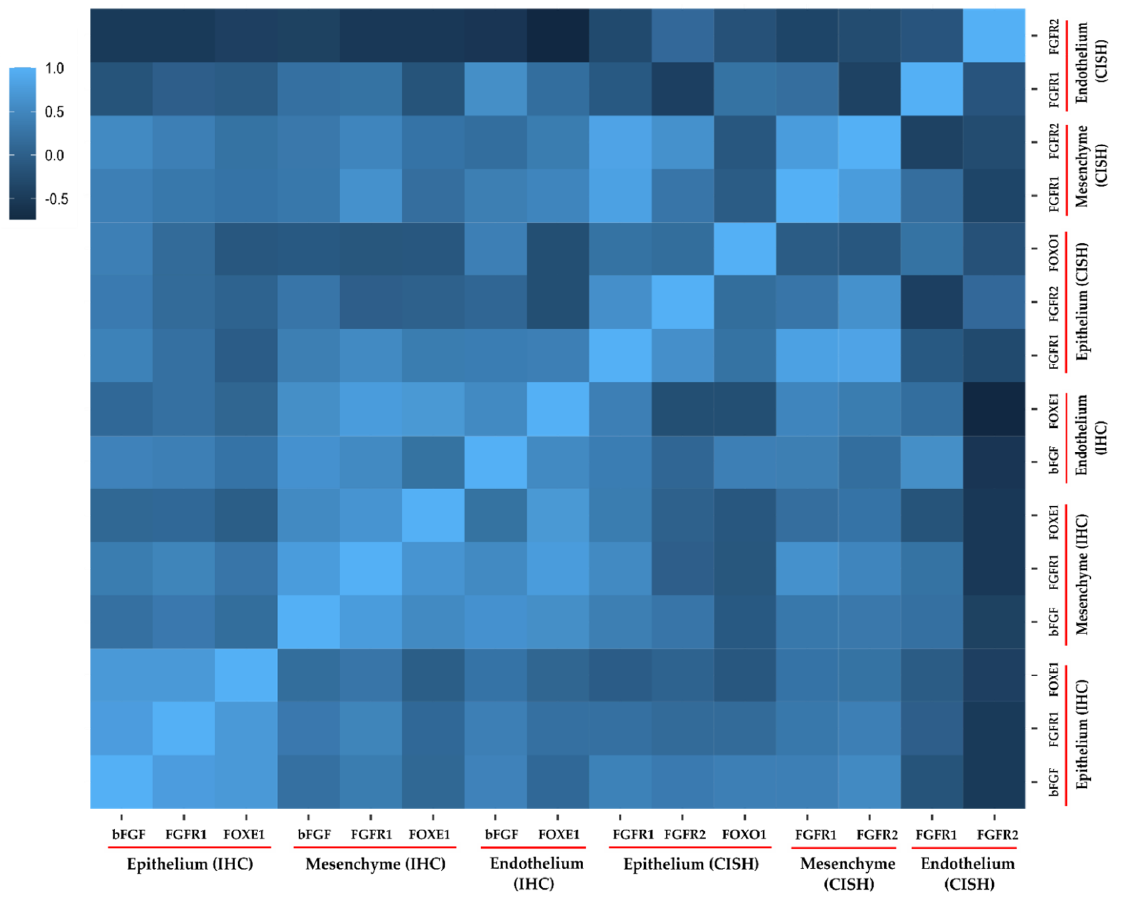
Figure 4. Correlation heatmap for different genes/proteins studied in the present study. The legend shows the correlation strength as determined using Spearman’s rho ( ρ ). Mesenchyme refers to connective tissue. A standard interpretation scale was used, i.e., 0.01 to 0.19 indicated no correlation; 0.20 to 0.29 indicated a weak correlation; 0.30 to 0.39 indicated a moderate correlation; 0.40 to 0.69 indicated a strong correlation; and ≥ 0.70 indicated a very strong correlation. IHC denotes immunohistochemistry; CISH denotes chromogenic in-situ hybridization.